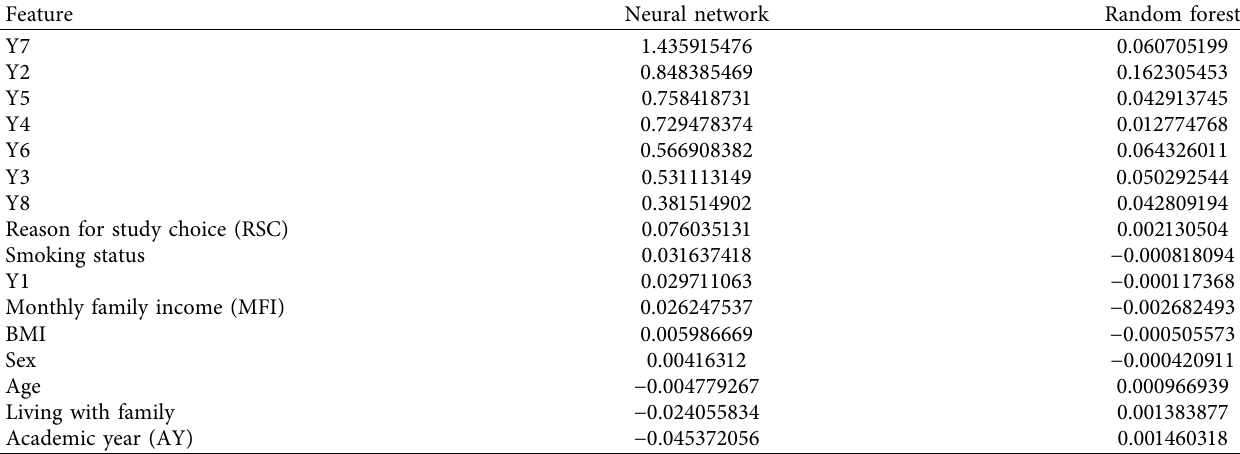
Figure 5: Heatmap of feature importance scores obtained from random forest and neural network model’s feature importance method for the features of the young imposter syndrome dataset. Table 3: Feature importance scores obtained for the features of the young imposter syndrome dataset employing neural network and random forest